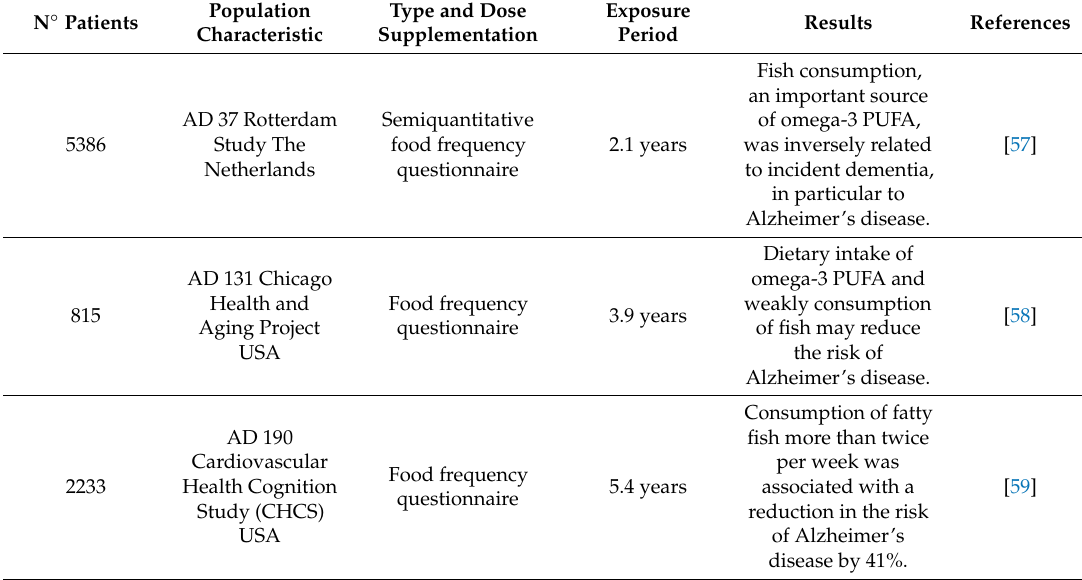
Table 6. Prospective observational studies assessing the impact of omega-3 fatty acids supplementation in AD patients.